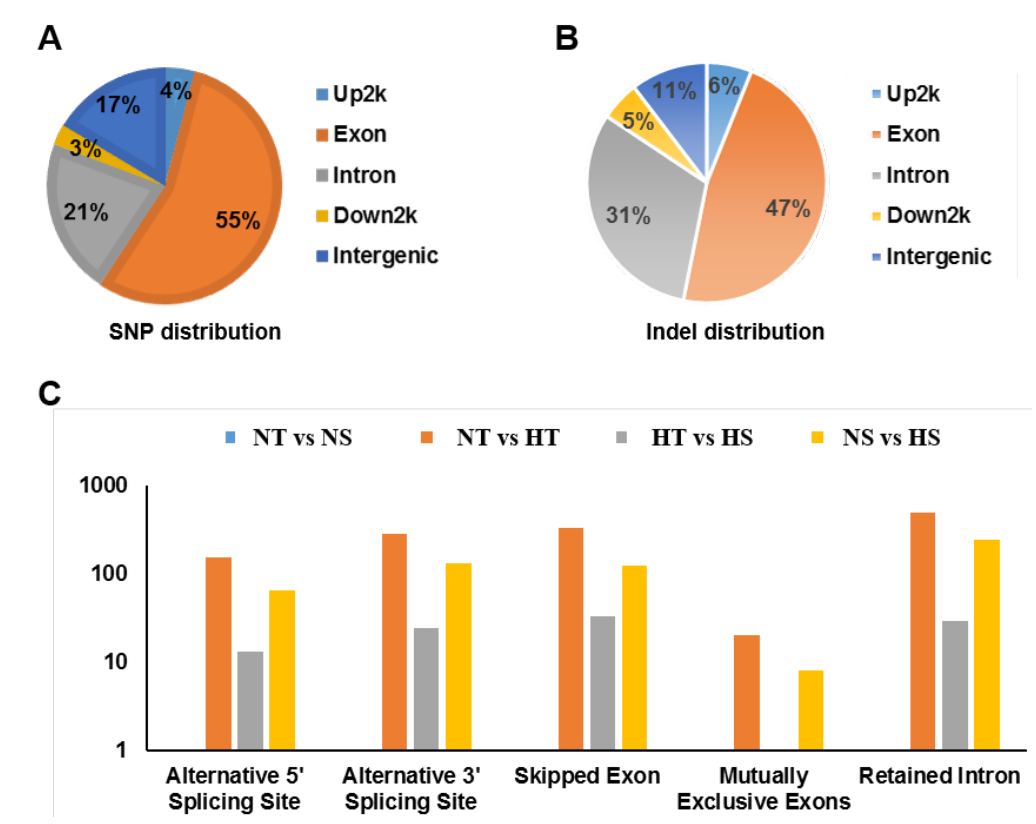
Figure 5. Quality of single nucleotide polymorphisms (SNPs), insertion/deletions (Indels), and al- ternative splicing sites in NT, NS, HT, and HS. NT, normal growth condition under 25/18 °C and water; NS, normal growth condition under 25/18 °C with 1 mM Spd treatment on plants; HT, high temperature growth condition on 38/28 °C and water treatment; HS, high temperature growth con- dition on 38/28 °C with 1 mM Spd treatment on leaves. Note: Relative distribution of SNPs ( A ) and Indels ( B ) in all data sets; ( C ) Numbers of alternative splicing sites (ASs) in five different types — alternative 5′splicing site, alternative 3′splicing site, skipped exon, mutually exclusive exons, and retained intron. Assays of ASs were performed between NT and NS, NT and HT, HT and HS, and NS and HS.